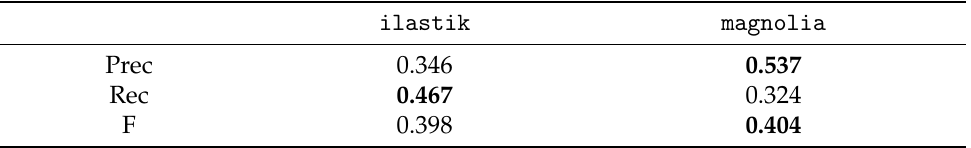
Table 1. Average quantitative results obtained by ilastik and MagNoLia on the images in the ALS- GT dataset for the segmentation of MNs. Each row corresponds to a different performance measure, and the best results for each performance measure are put in boldface for better visualisation.